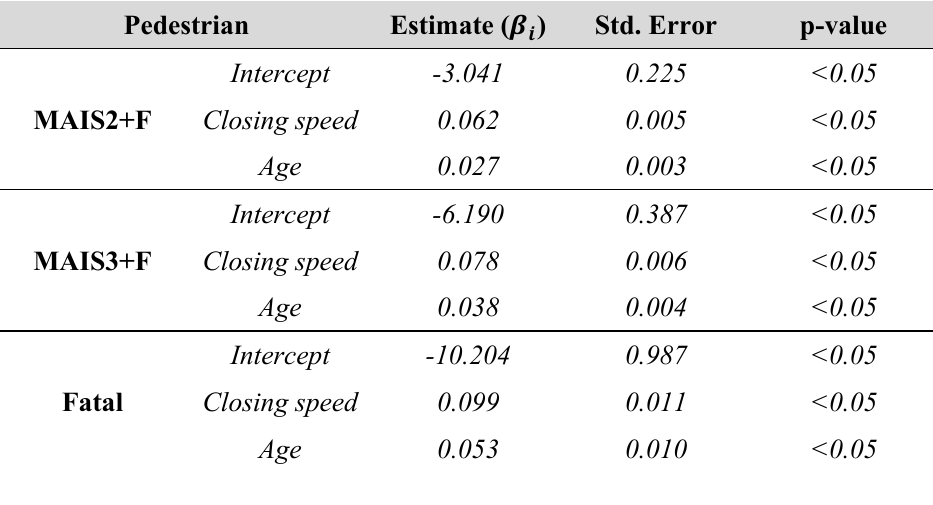
Table 2. Pedestrian injury risk models: Logistic regression coefficient estimates according to Equation (1)